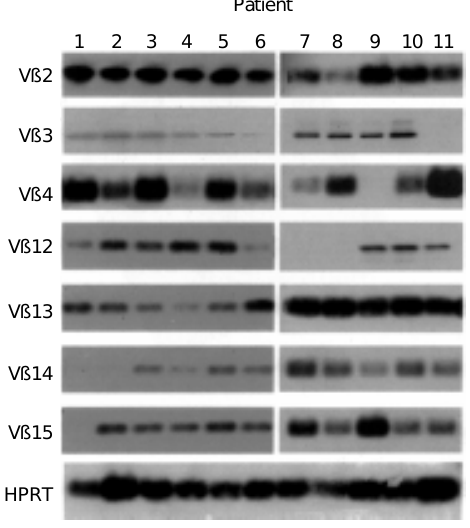
Figure 2. Peripheral blood mono- nuclear cell expression of Vß families as measured by RT- PCR. Patients with congenital ocular toxoplasmosis (1 to 11) were evaluated for the presence of the Vß families shown. Hypo- xanthine phosphoribosyltrans- ferase (HPRT) was used as a housekeeping gene